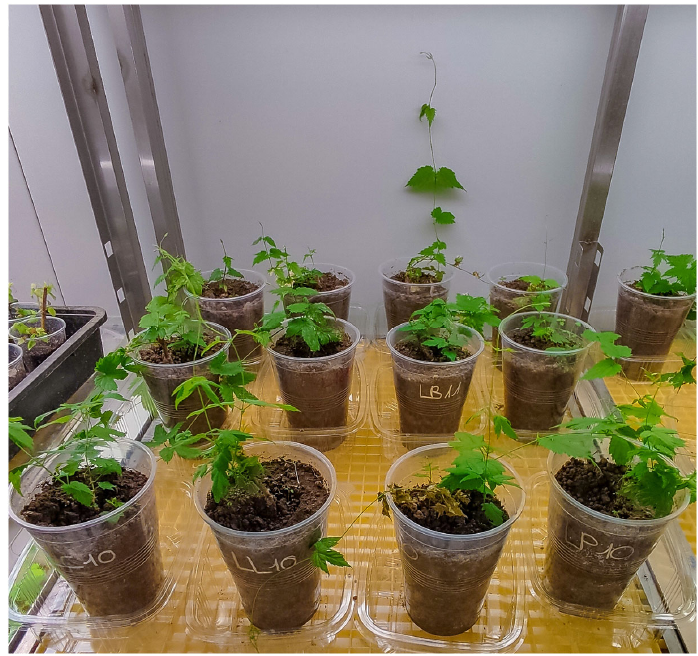
Figure 6. Hop plantlets in the climate chamber during the growth promotion assay. Figure 7 represents the mean values of the development measures taken one and two